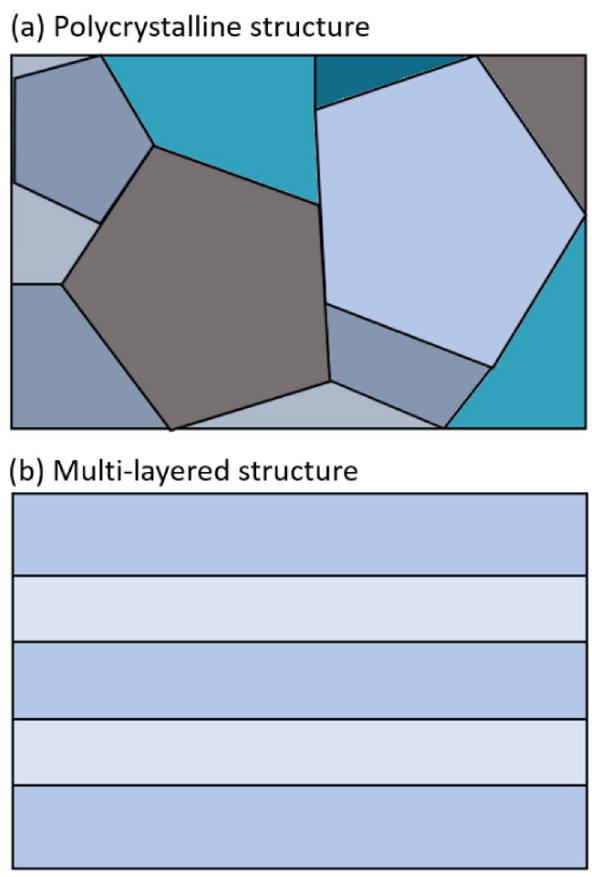
Fig. 11 Structures of a polycrystalline graphene nanoribbon with pentagon (blue shaded area), heptagon (orange), and octagon (yellow) defects obtained by joining two layers with an inclination angle of 24° [169], b Bi 2 Te 3 one quintuple layer-thick slab (Te and Bi atoms are presented with orange and purple spheres, respectively) [173], and c p -type LaNiO 3 /SrTiO 3 (001) superlattice with two p -type inter- faces (La, Sr, and O atoms are purple, green, and red, respectively. Light and dark blue octahedra are centered around Ti and Ni ions, respectively) [180]. Adapted with permission from Refs. [169, 173, 180]. Copyrights 2015 and 2017 American Physical Society, and 2010 American Institute of